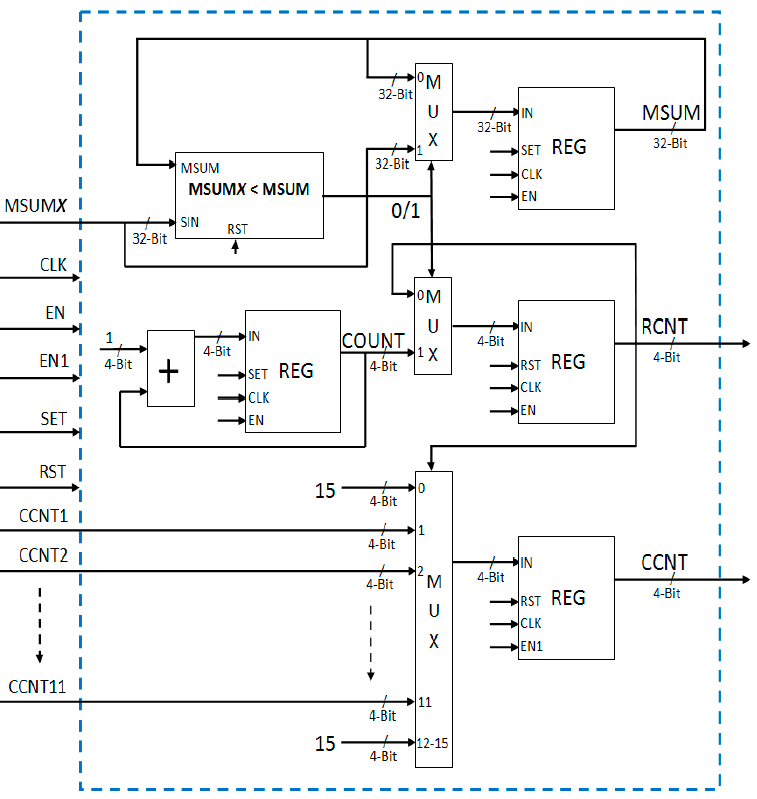
Figure 11. Internal architecture of minimum sum value computation Stage-2 unit. MSUM X → Minimum Sum Value of Xth Row; MSUM → Minimum Sum Value; CCNT → Column Counter; RCNT → Row Counter; COUNT → Counter; MUX → Multiplexer; REG →